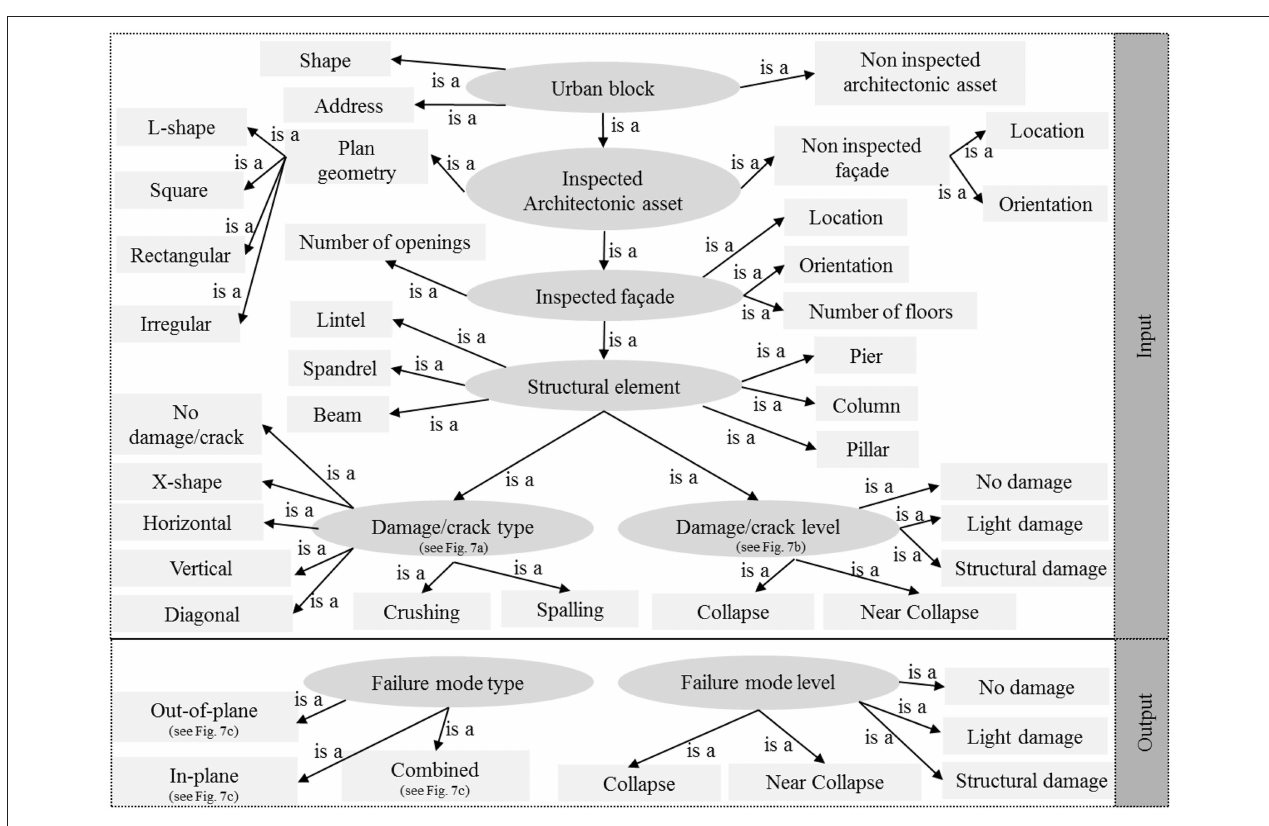
FIGURE 6 | Ontology defined for